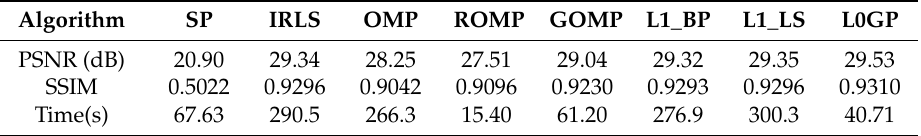
Table 3. The quantitative results of different arithmetics.